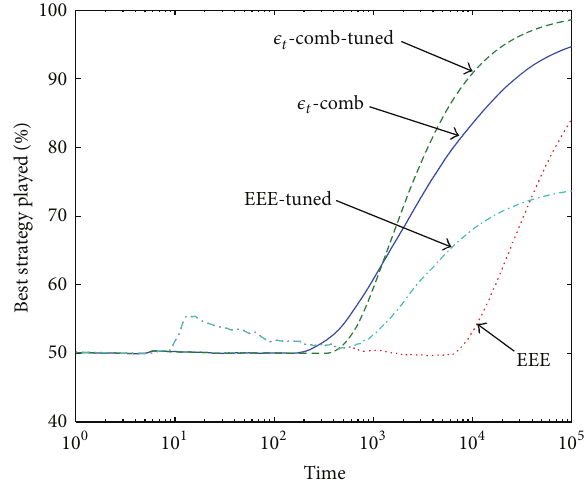
Figure 3: Percentage of selections of the best strategy of (tuned) 𝜖 𝑡 - comb(2 PLAs) and of (tuned) Exp4/NEXP/EEEs for the distribution ( 0.9, 0.8, 0.8, 0.8, 0.7, 0.7, 0.7, 0.6, 0.6, 0.6